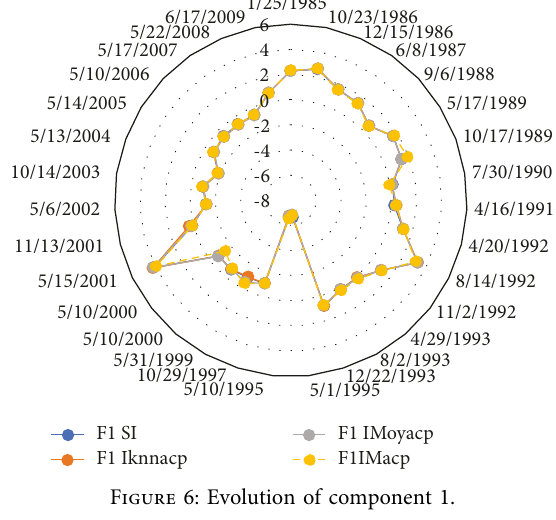
Figure 6: Evolution of component 1.